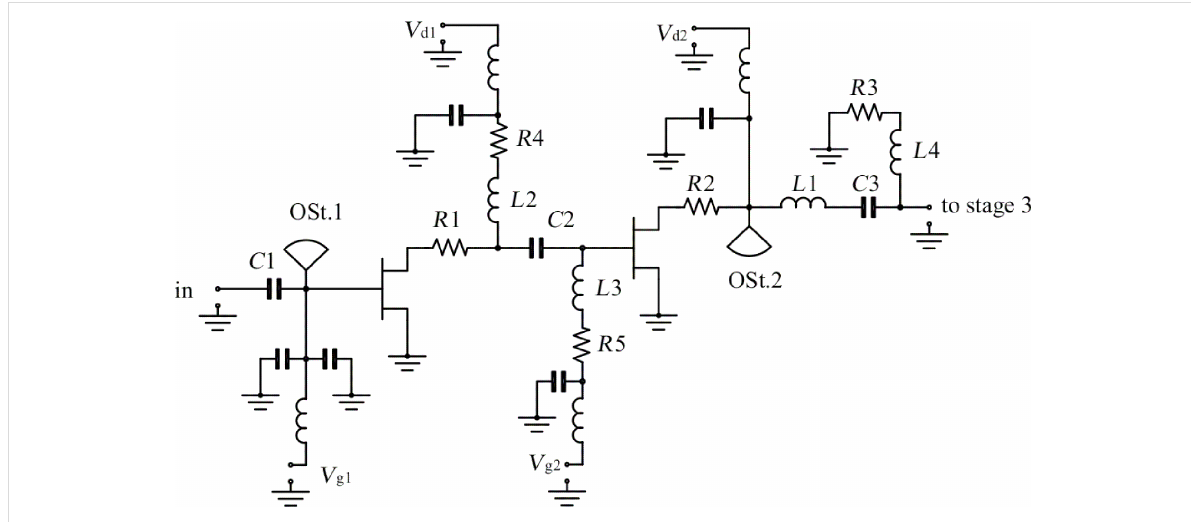
Figure 1: Schematic of the 6–12 GHz cryogenic LNA. The important component values are: C 1 = 0.6 pF, C 2 = 0.3 pF, C 3 = 0.2 pF, L 1 = 0.8 nH, L 2 = 0.8 nH, L 3 = 0.6 nH, L 4 = 3 nH, R 1 = 10 Ω , R 2 = 18 Ω , R 3 = 25 Ω , R 4 = 25 Ω , R 5 = 10 Ω . The capacitors and resistors are realized in 0402 packages and the inductances are realized in a 0201 package (OSt.: open stub lines). The other passive components do not affect to the signal matching and are used for filtering of the bias lines.